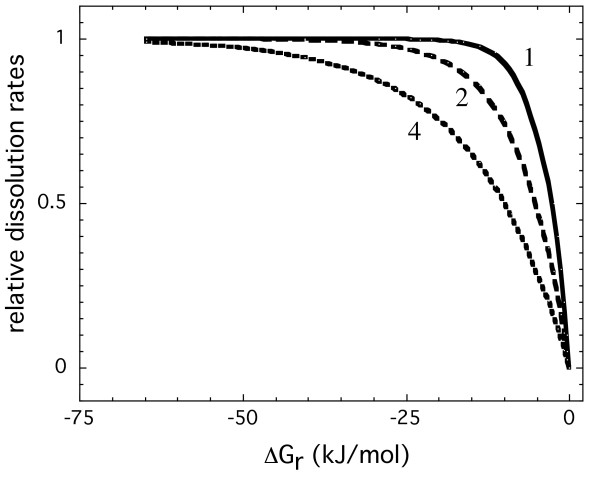
Predicted rates, normalized to the maximum rate, as a function of the Gibbs free energy of the reaction for different Temkin's co-efficient (indicated by the numbers shown in the figure close to the lines).